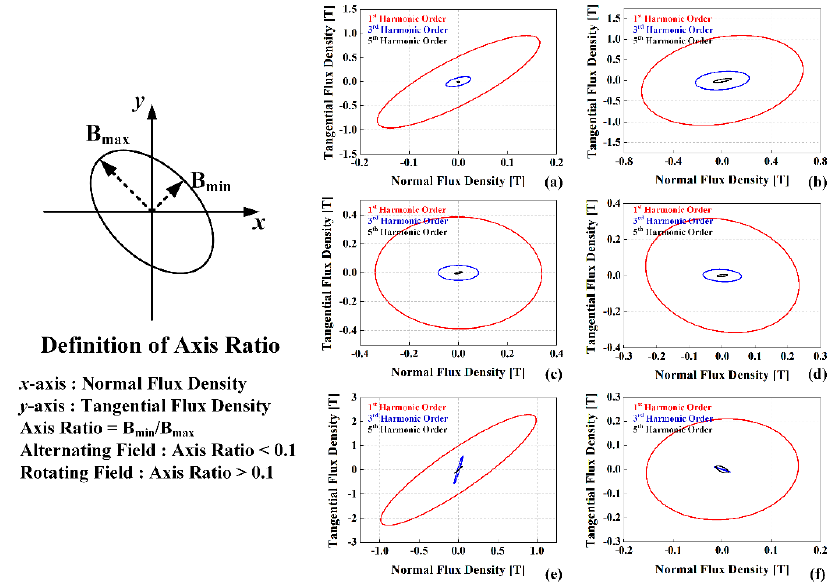
Figure 6. Analysis of the behavior of the magnetic field in each segmentation area: ( a ) point 1-29; (b) point 1-504; (c) point 2-70; (d) point 2-75; (e) point 3-38; and (f) point 3-499.